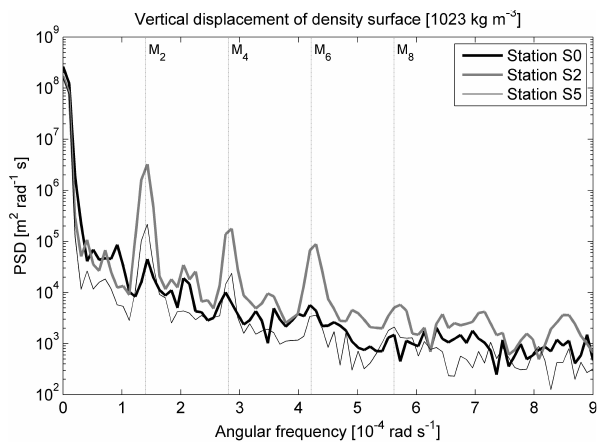
Fig. 10. Power spectral density (PSD) for the 1023kgm − 3 density surface at stations S0, S2 and S5 as a function of the angular fre- quency. According to the harmonic analysis, the PSDs of M 2 , M 4 and M 6 are significant (95%) at both S2 and S5. At S0 only the PSDs of M 2 and M 3 are